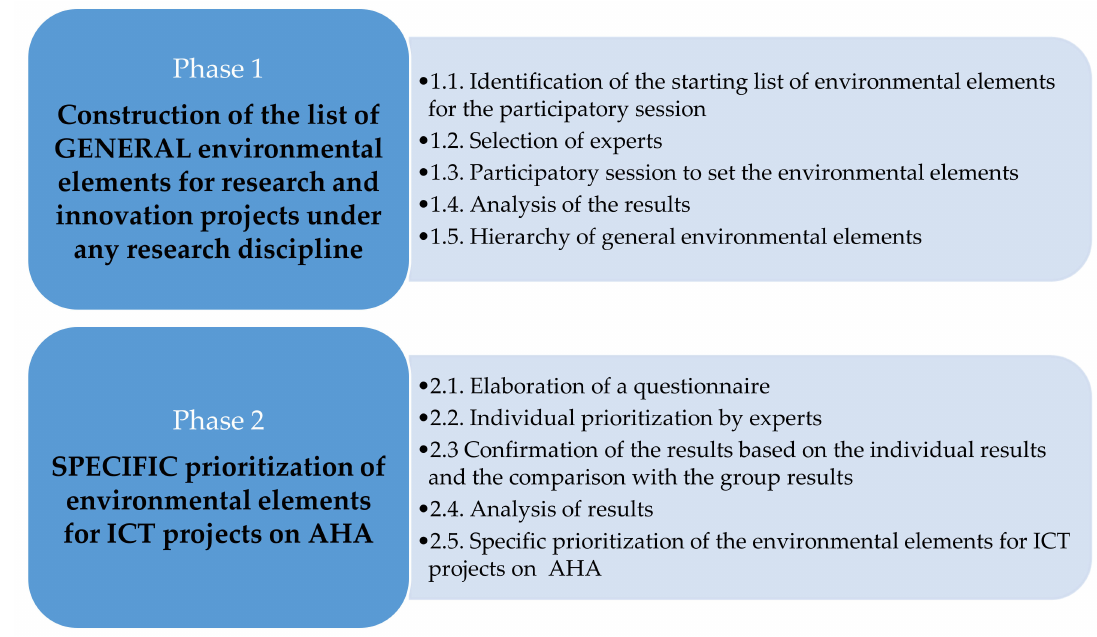
Figure 1. Methodology of the